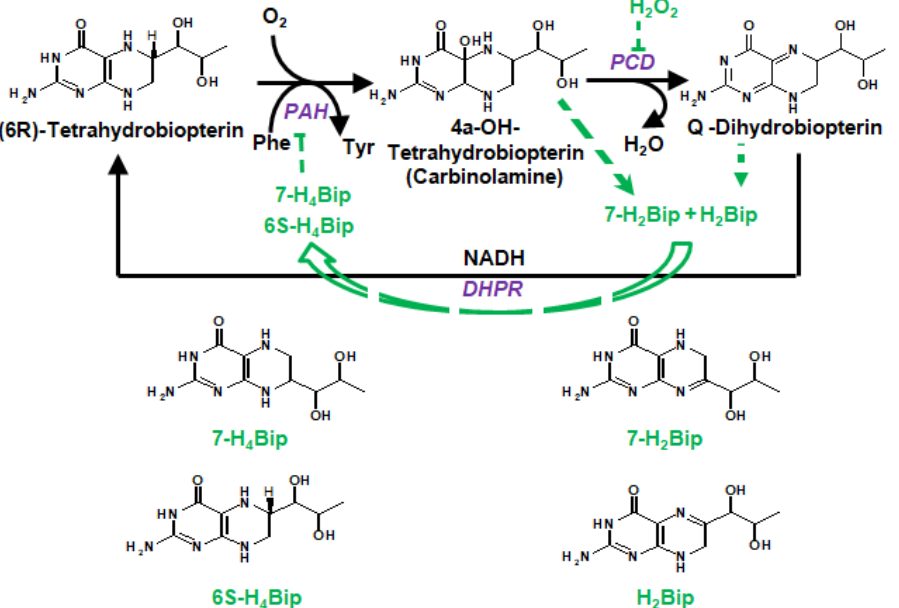
Figure 25. Disruption of the H 4 Bip regeneration cycle under oxidative stress and inactivation of phenylalanine hydroxylase [30] (black lines show normal H 4 Bip regeneration cycle, violation of the regeneration cycle is shown by green dotted lines). PAH—phenylalanine-4-hydroxylase; PCD—pterin-4a-carbinolamine dehydratase; DHPR—dihydropteridine reductase. 7-H 2 Bip—7-dihydrobiopterin, or dihydroprimapterin. © 2022 Taylor and Francis.